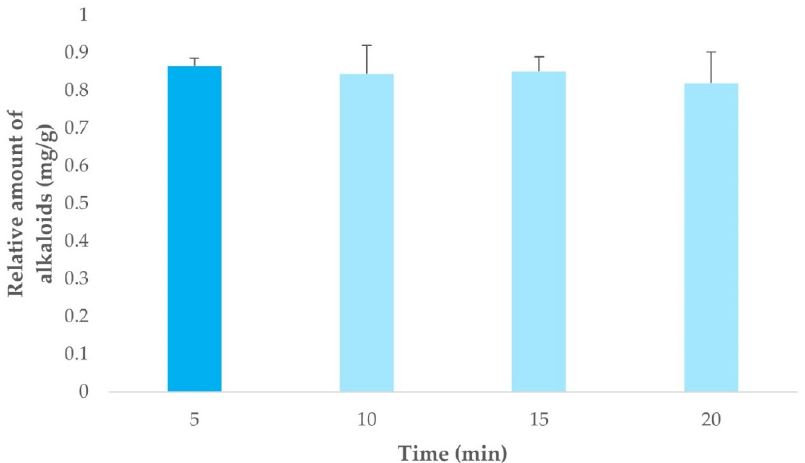
Figure 7. Extraction yields obtained ( n = 3) under optimal extraction conditions while varying the extraction times.